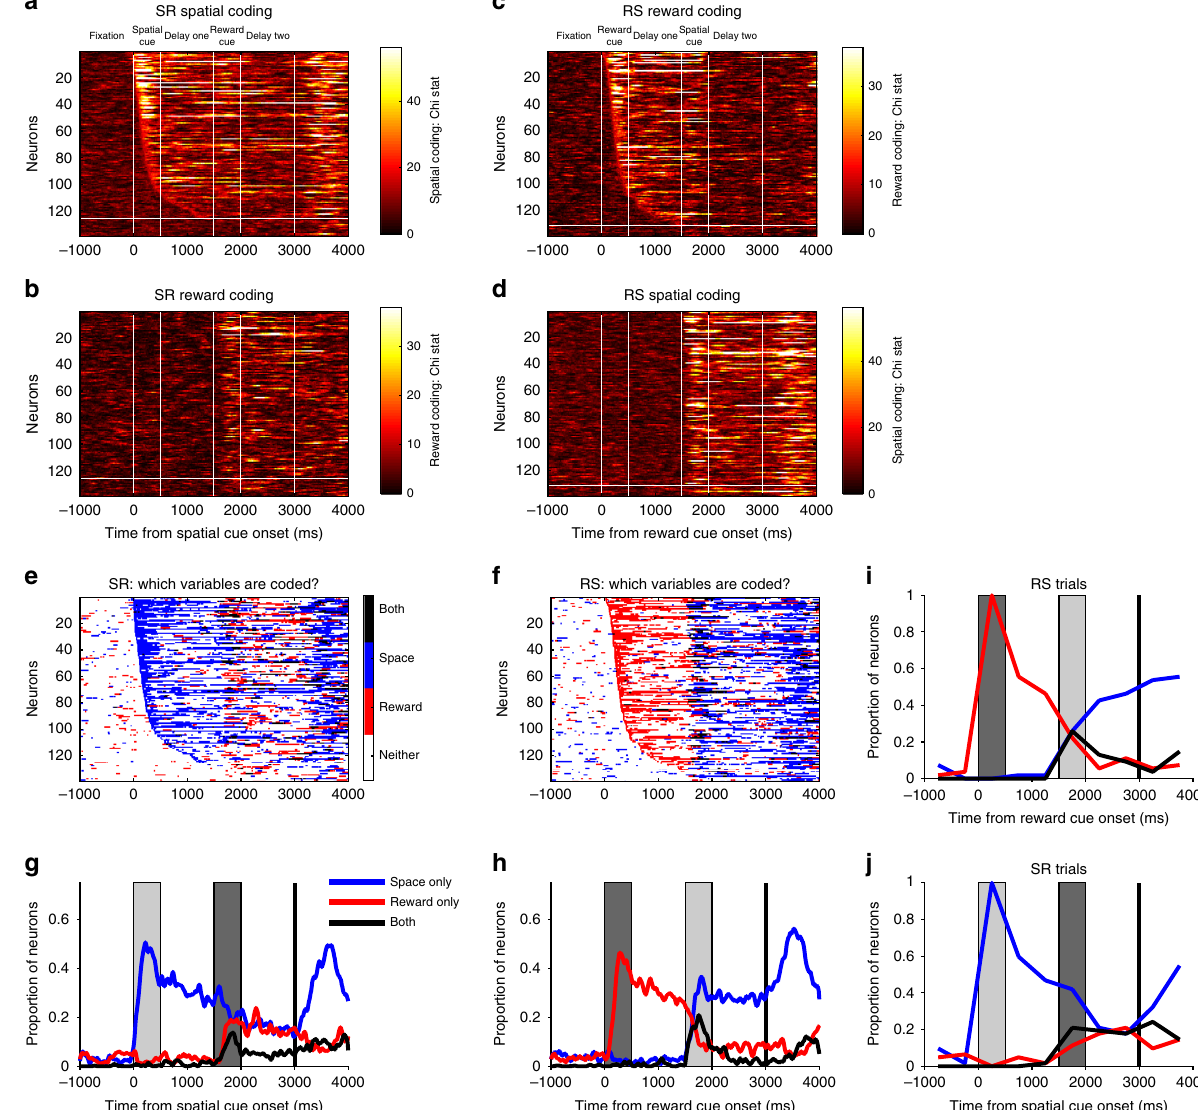
Fig. 7 Flexibility of single-neuron selectivity. a – b SR-trials: Single neuron coding. a The heatmap shows the spatial coding of individual ventrolateral PFC neurons; each row of the matrix represents single-neuron selectivity. Neurons are sorted by their latency for spatial encoding; all neurons above the horizontal white line were selective for space either during cue presentation or delay-one. For many of these cells, selectivity is transient; few code space across extended periods of the trial. b Reward coding of individual ventrolateral PFC neurons. A large proportion of the neurons which were selective for space subsequently become selective for reward at cue two/delay-two (neurons are sorted in the same order as in a ). c – d RS-trials: Single neuron coding. Neurons are now sorted by their latency for reward encoding ( c ), with all neurons above the white line selective during cue presentation or delay-one. Reward encoding is primarily transitory in nature. d This heatmap shows that many of the neurons initially coding reward go on to code the spatial location when this cue is presented. e – f The task variables signi fi cantly (Methods) encoded by each neuron at each timepoint are plotted for SR ( e ) and RS-trials ( f ). g – h Fraction of neurons selective for either or both task factors across SR ( g ) or RS-trials ( h ). Presentation of the second stimulus reduces the number of neurons selective for the initially presented cue. i – j Switching of selectivity across a trial. Neurons are included in this analysis if they were selective during the presentation of the fi rst cue. The selectivity pattern of these neurons is pro fi led across time. On SR-trials ( j ), only a minority of cue selective neurons retain an exclusive representation of space across the entire trial; many neurons gain reward coding, some at the expense of spatial selectivity, and others in addition to this. On RS-trials ( i ), a similar dynamics are